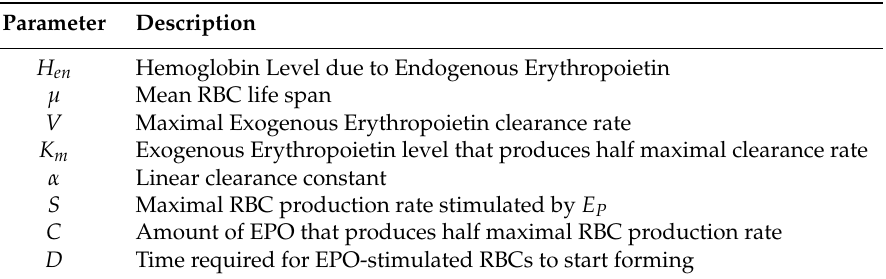
Table 5. Parameters for the PK/PD